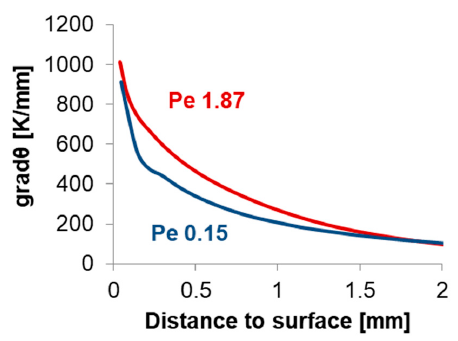
Figure 15. Temperature gradients for Pe = 0.15 (blue) and Pe = 1.86 (red) during the heating period at approximately 800 °C on the surface.